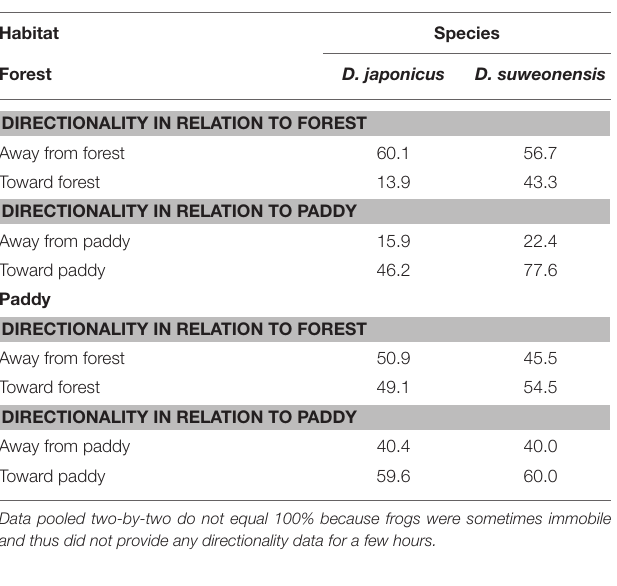
TABLE 6 | Descriptive statistics for the directionality of the movements exhibited by Dryophytes suweonensis and D. japonicus in relation to the type of site selected for the release (i.e., rice paddy or forest) during the spring tracking experiments.